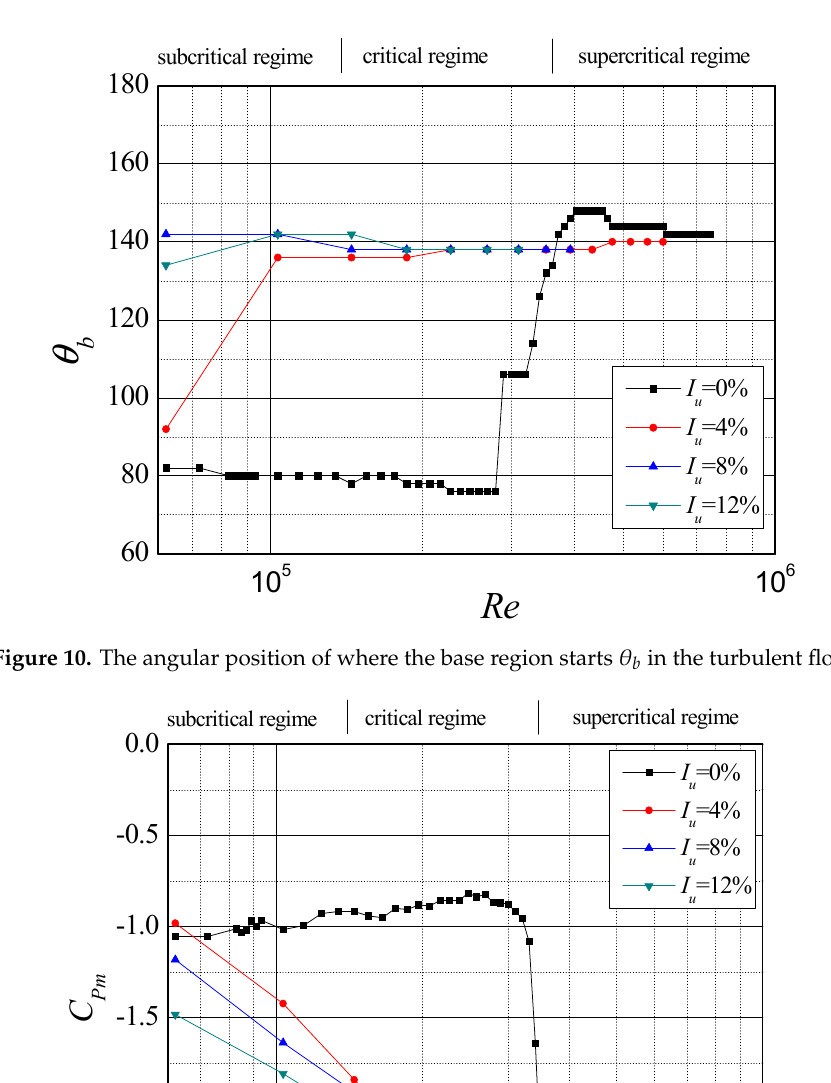
Figure 9 . The mean wind pressure coefficient within the base region C pb in turbulent.